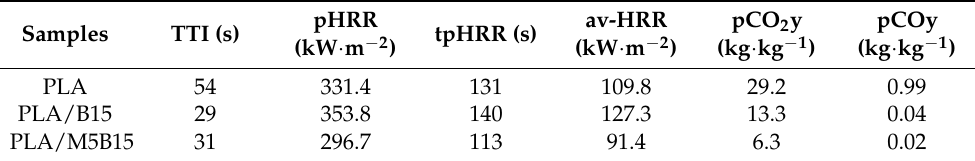
Figure 3. The heat release rate (HRR) curves of PLA, PLA/B15, and PLA/M5B15 composites. Table 4. Cone calorimeter test (CCT) data of PLA, PLA/B15, and PLA/M5B15 composites.